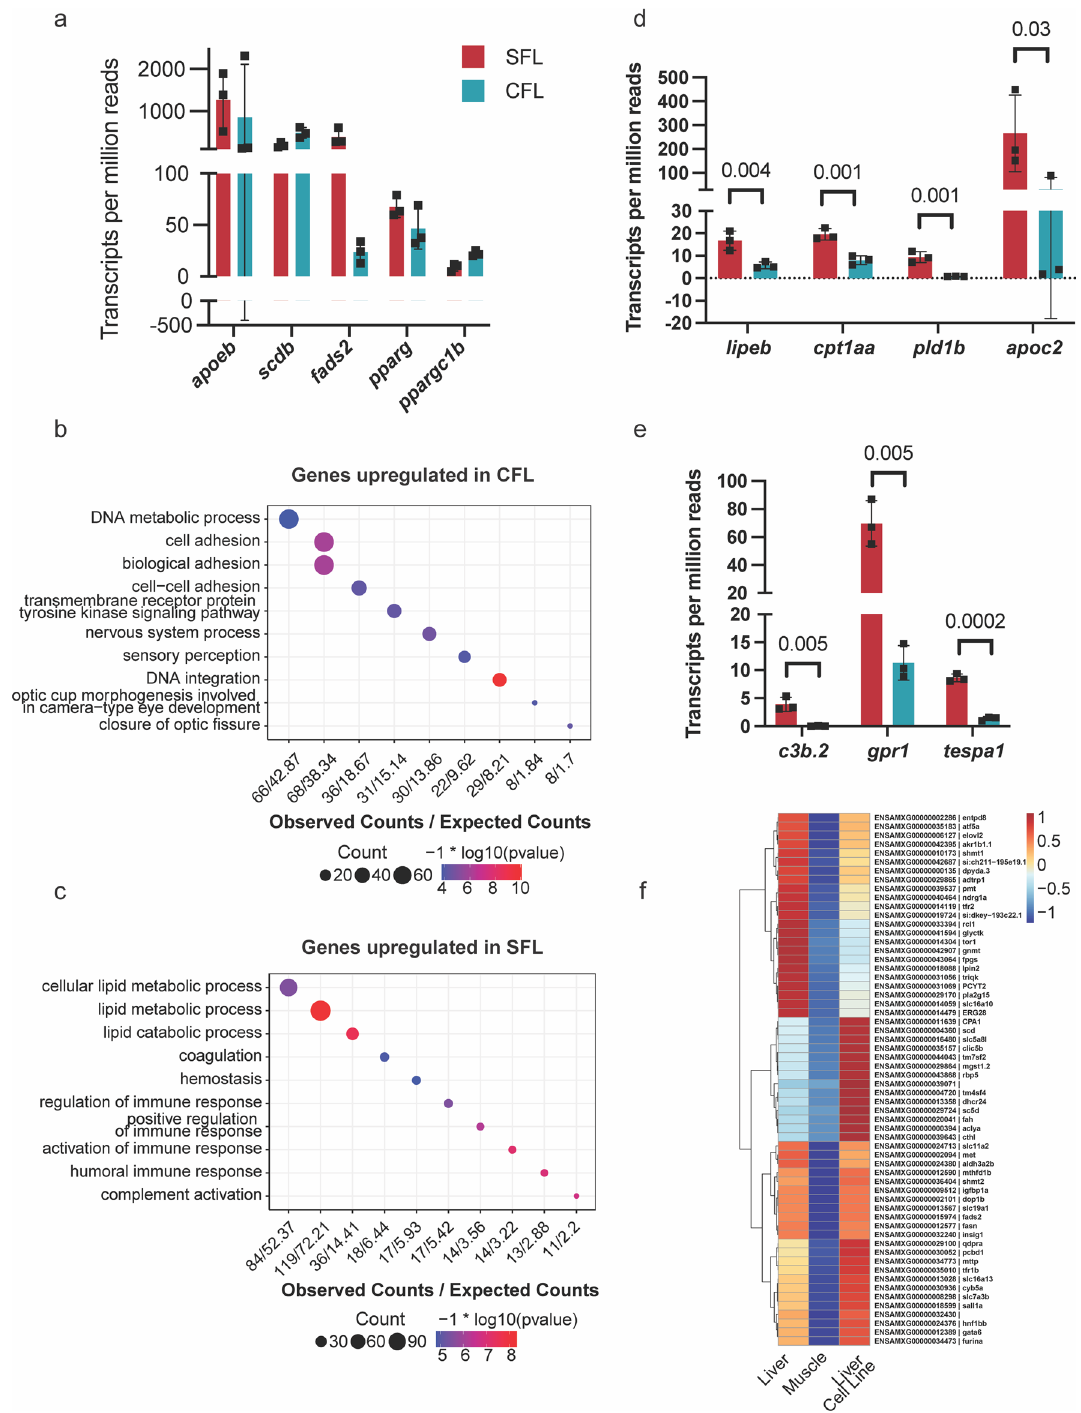
Figure 4. ( a ) Expression levels for key liver metabolism genes. ( b ) GO terms enriched among genes upregulated in SFL vs CFL. ( c ) GO terms enriched among genes downregulated in SFL vs CFL. ( d ) Genes belonging to ‘lipid catabolic process’ that are upregulated in SFL. ( e ) Genes belonging to ‘activation of immune response’ that are upregulated in SFL. The bar graphs represent standard deviation around mean values. ( f ) Heatmap depicting average gene expression levels of genes that are not expressed in the muscle but are expressed in both liver tissue and liver cell lines. p-values were calculated using a two-tailed Student’s t